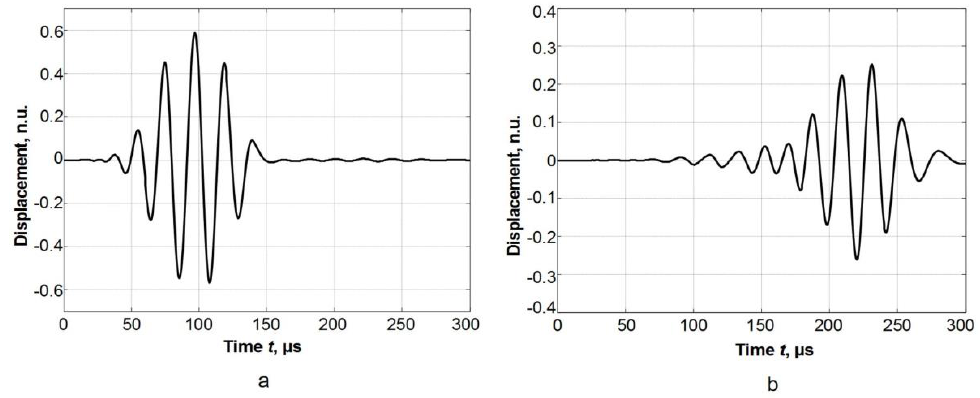
Figure 5. Normalized modulus of particle velocity at different instances of time in the case of a 1 × 5 mm 2 excitation zone. ( a ) 150 µs, ( b ) 300 µs.